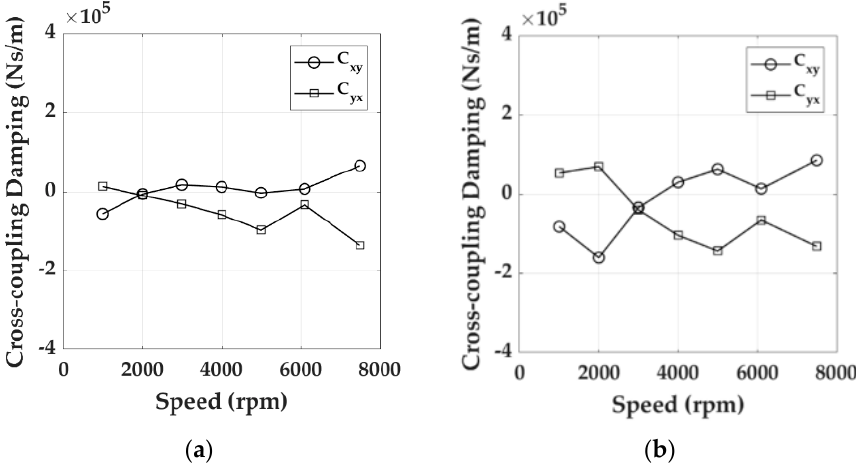
Figure 34. Direct Lube Rocker Pivot bearing synchronous cross-coupling damping: ( a ) 0.8 MPa, ( b ) 1.7 MPa.